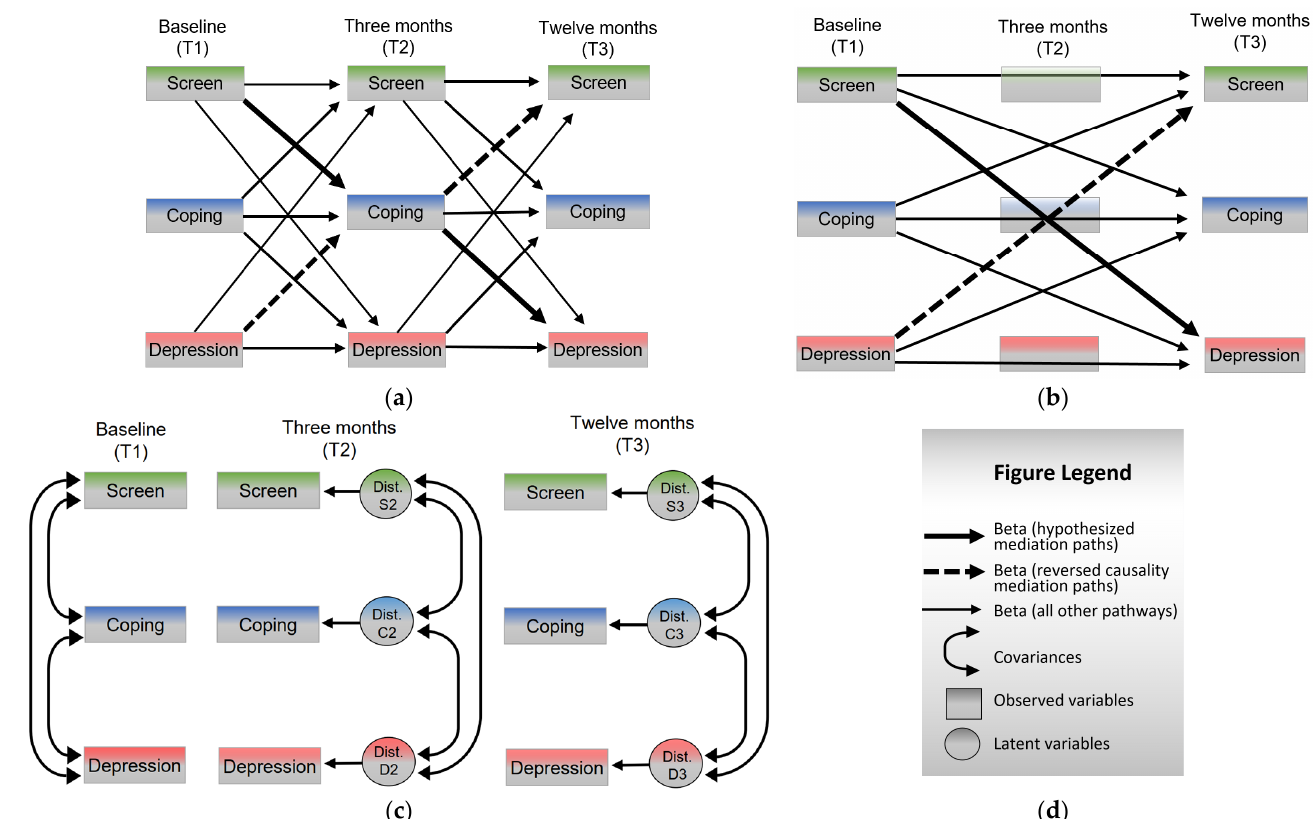
Figure 1. Conceptual illustration of the structural regression (pathway) model, divided into three parts to avoid clutter. Panel ( a ) shows indirect effects regression paths; panel ( b ) shows direct effects regression paths; panel ( c ) shows covariances and disturbance (error) terms; panel ( d ) shows the figure legend. The model was run unadjusted for gender and perceived socioeconomic status.